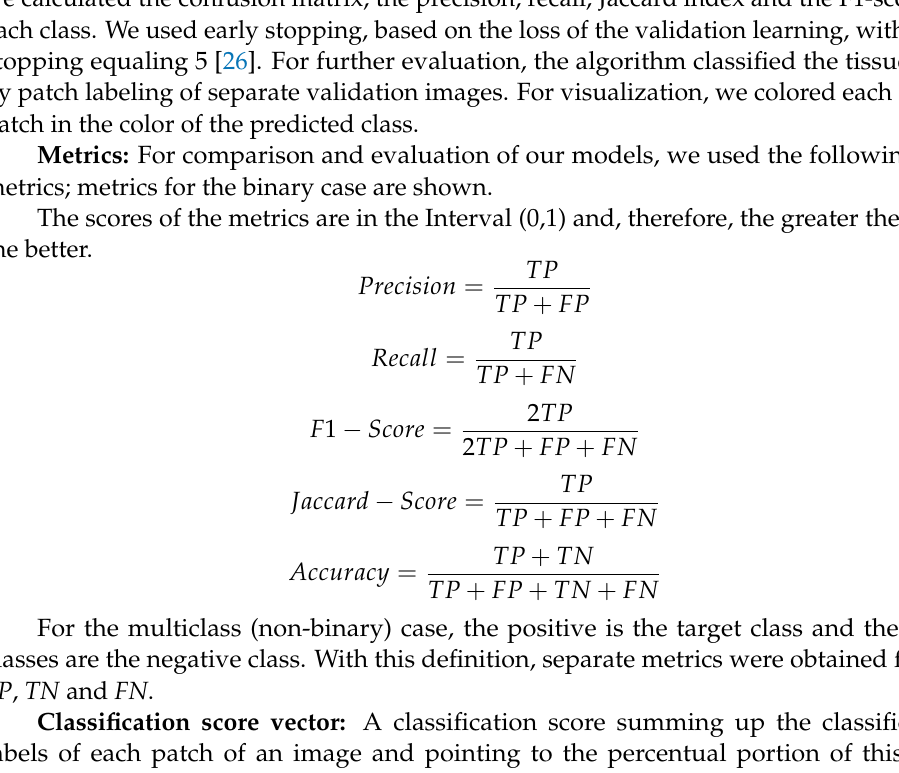
Classification score vector: A classification score summing up the classification labels of each patch of an image and pointing to the percentual portion of this class was determined.